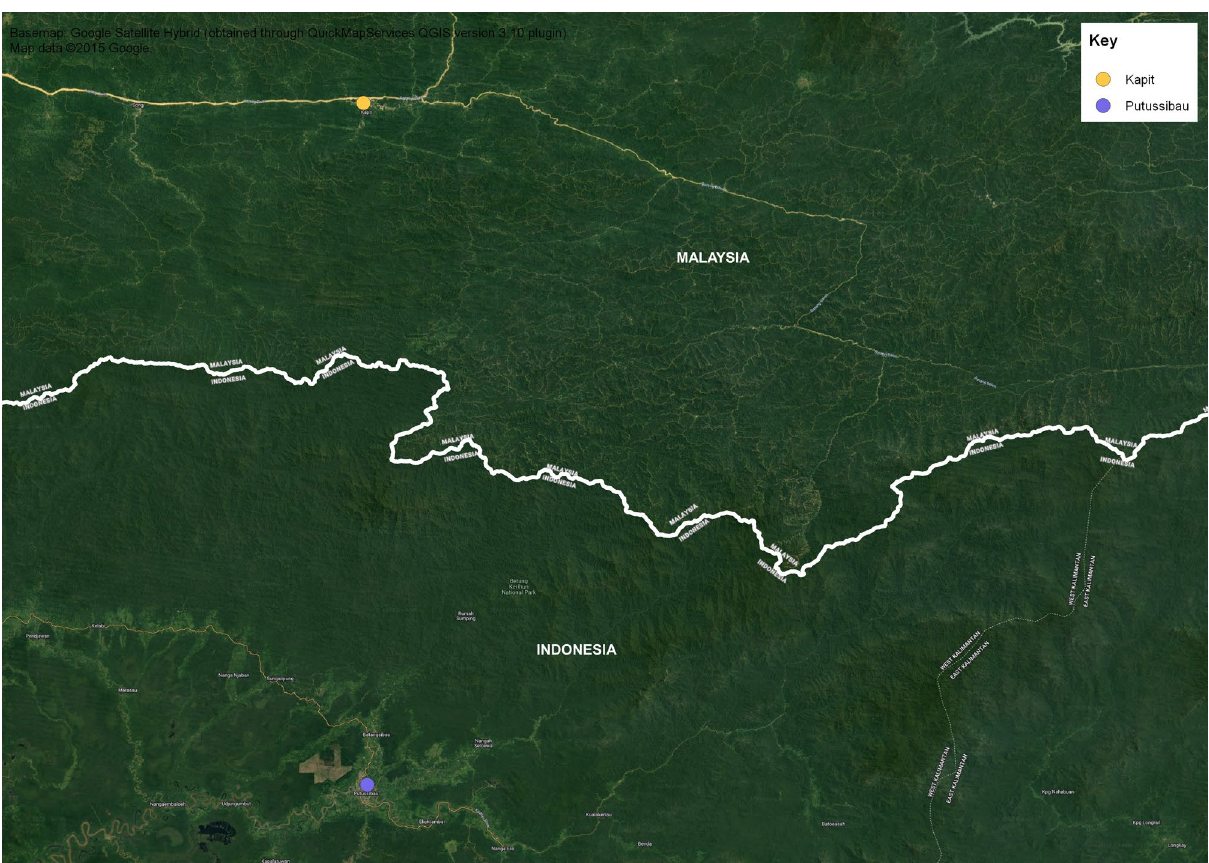
Figure 4. Sattelite view of Kalimantan-Sarawak border showing extensive road system on Sarawak side and a paucity of jungle access roads on the West Kalimantan